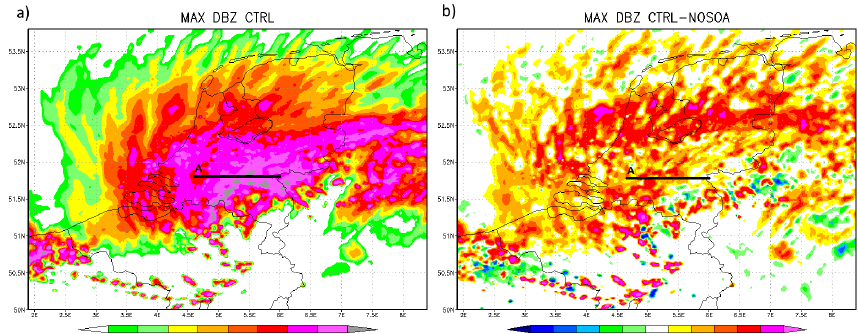
Figure 15. Maximum dBZ at 06:00UTC of 17 May for CTRL run (a) and difference of maximum dBZ between CTRL and NOSOA simulations (b) . The solid black line represents the cross section A used to plot vertical profiles reported in Fig.